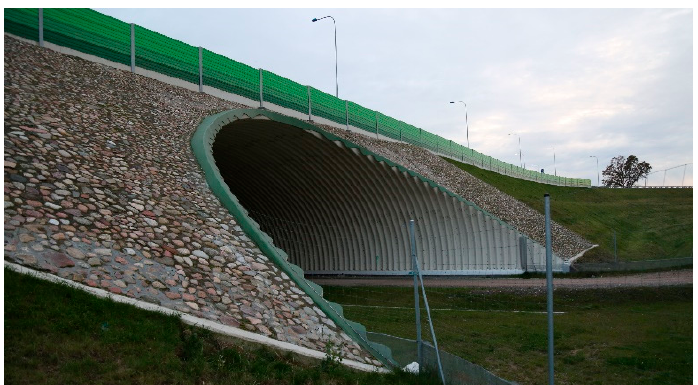
Figure 2. Close up of one of the bridge sides taken in October 2019.